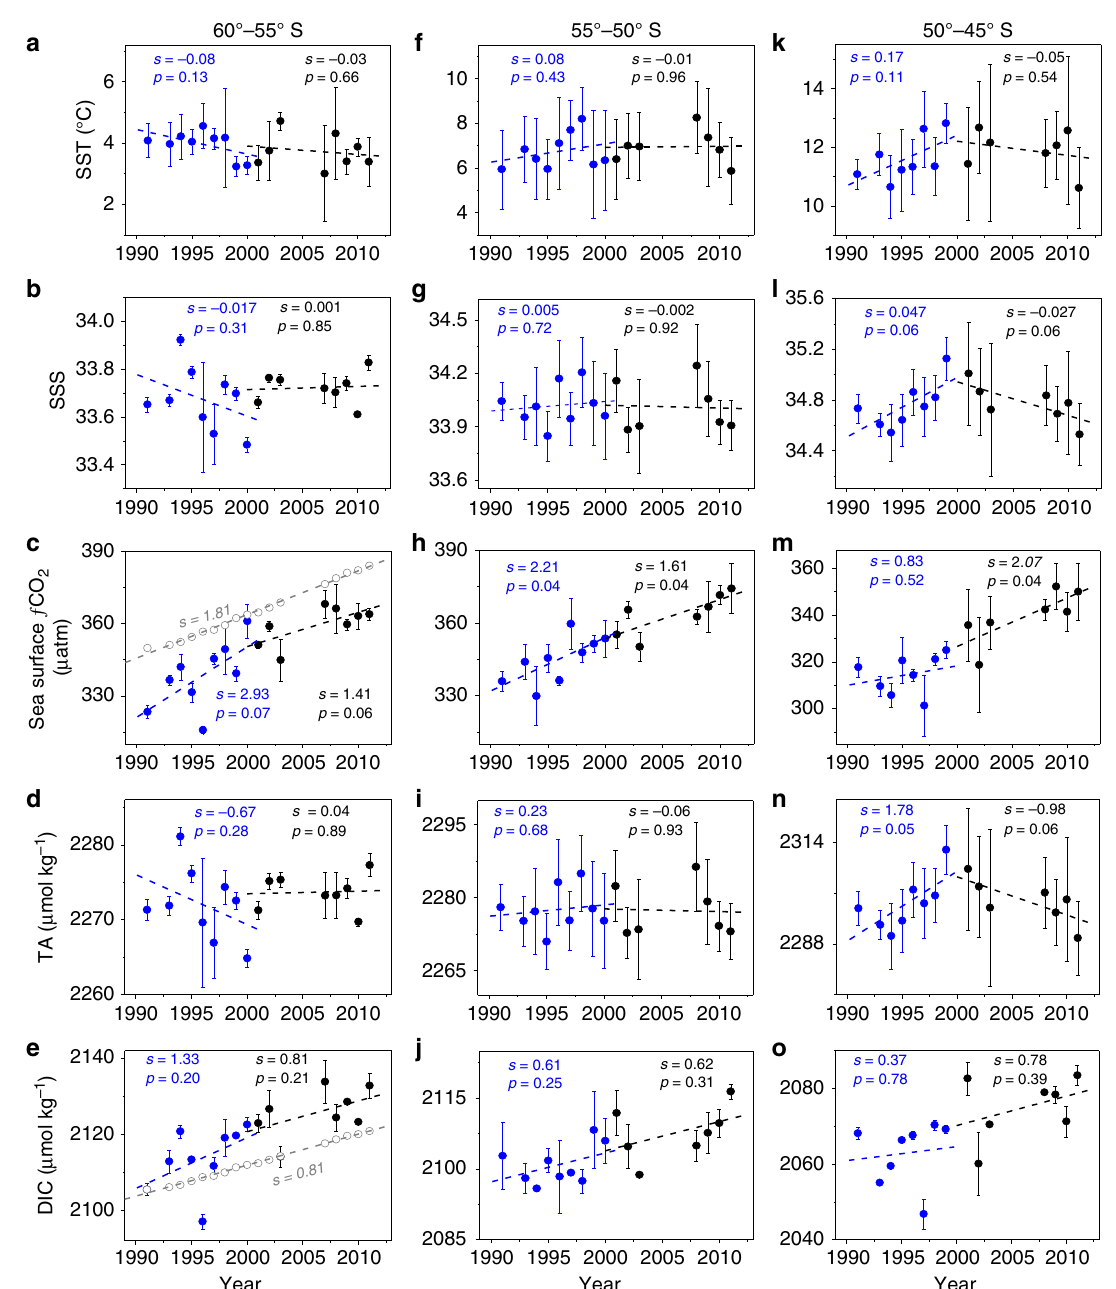
Fig. 2 Temporal variability in sea surface temperature, salinity, and carbonate parameters in January in three latitudinal bands. a – e Sea surface temperature ( a , SST), salinity ( b , SSS), sea surface CO 2 fugacity ( c , f CO 2 ), estimated total alkalinity ( d , TA) and calculated dissolved inorganic carbon ( e , DIC) at 60° – 55° S. f – j Show the same parameters but at 55° – 50° S; k – o also show the same parameters but at 50° – 45° S (see 'Methods'). The vertical bars show one standard deviation, which re fl ects the spatial variability within each latitudinal band. Linear regression analyses were performed for the periods 1991 – 2000 (blue) and 2001 – 2011 (black). Slopes ( s ) and p -values of the regression analyses are also shown (differentiated with blue and black colors for the two periods). A trend of p -value < 0.1 is regarded as statistically signi fi cant (90% con fi dence interval) due to the small sample numbers (<10). Also, the atmospheric CO 2 data (shown as f CO 2 ) observed at the GCO (Cape Grim, Tasmania) atmospheric CO 2 measurement station (ftp://aftp.cmdl.noaa.gov/ data/trace_gases/co2/ fl ask/) and the DIC values computed due solely to the atmospheric CO 2 increase (see 'Methods') are indicated with open gray circles in Fig. 2c,